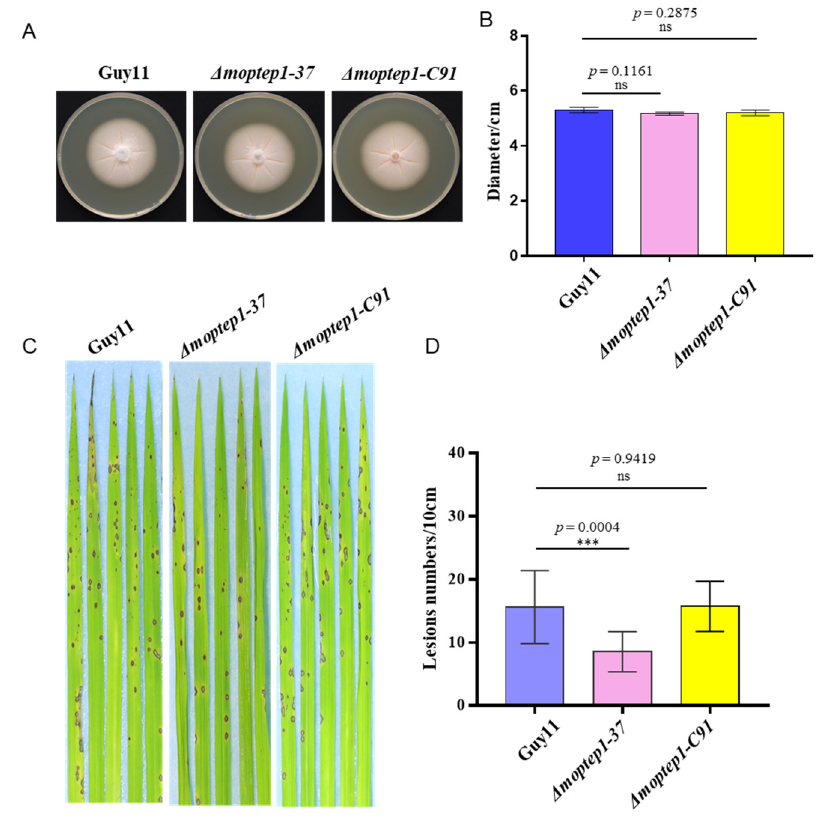
Figure 4. Pathogenic analysis of Δ moptep1 mutants . ( A ) Colony morphology of wild-type strain Guy11, Δ moptep1-37, and Δ moptep1-C91 . ( B ) Statistical analysis of the colony diameters. Bar indicates the standard deviation of three replicates. Significance analysis was analyzed by Student’s t -test, and ns means no significance. ( C ) Pathogenic results of Δ moptep1 mutants. Conidial suspensions of Guy11, Δ moptep1-37 mutant, and the complement strain Δ moptep1-C91 were sprayed on rice seedlings. Diseased symptoms on leaves were photographed after 7 days post inoculation (dpi). ( D ) Statistics analysis of the number of lesions. Experiments were repeated three times. Bar indicates the standard error of 15 leaves. Significance analysis was analyzed by Student’s t -test; *** indicates p < 0.001.